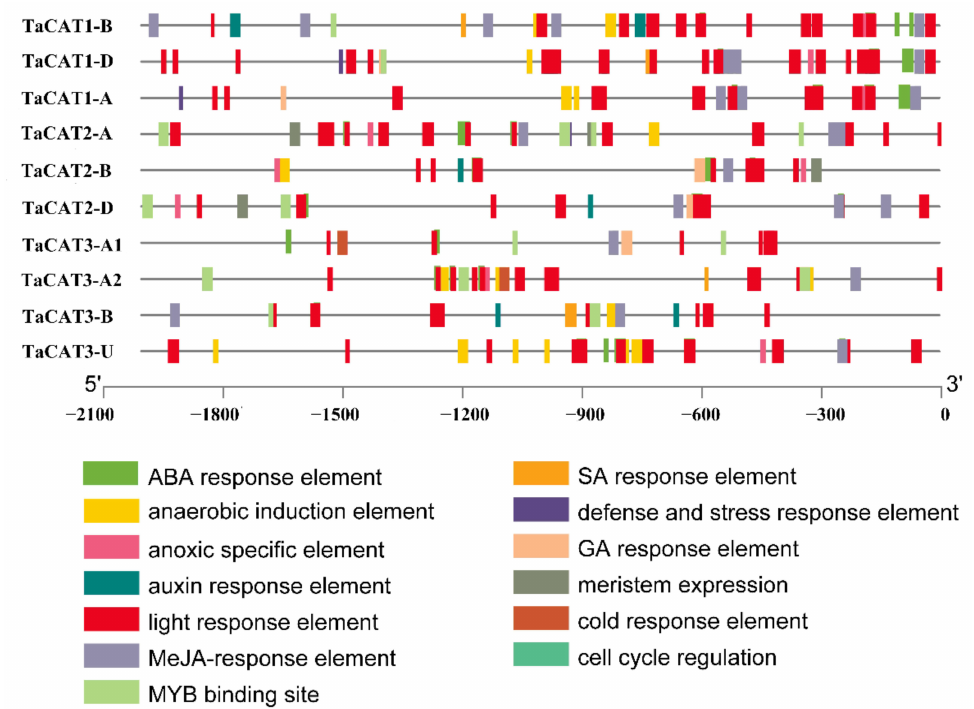
Figure 5. Analysis of promoter sequences of TaCATs . 2 kb 5 (cid:48) upstream region from the transcription start site (TSS) was selected and analyzed in silico using the Plantcare website. The analysis showed the presence of various cis-regulatory elements at the promoters of TaCAT genes. Different motifs were indicated by different color